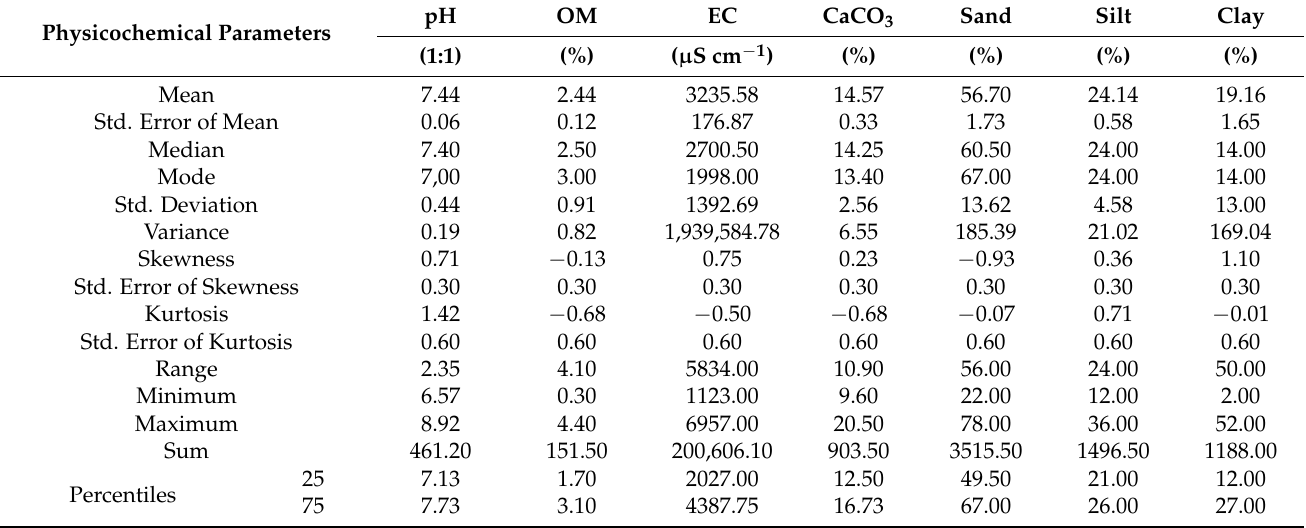
Table 1. Descriptive statistics of physicochemical parameters of the soil samples (four-year study, n =